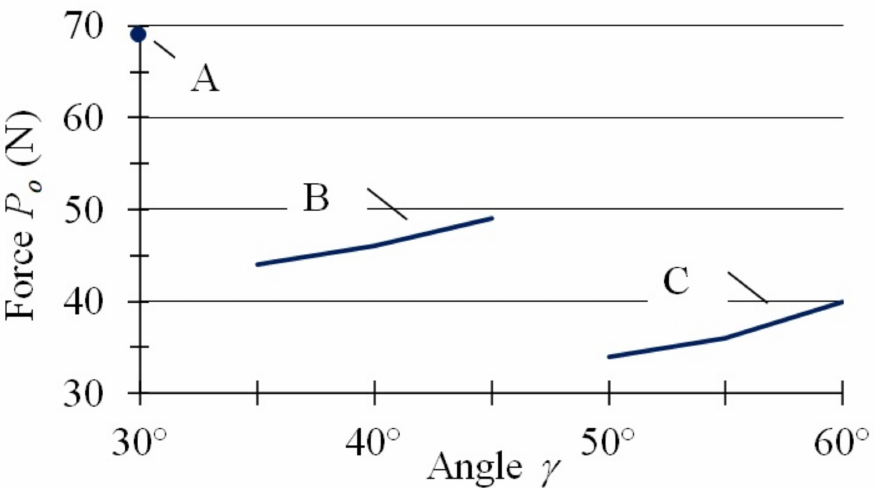
Figure 8. The dependence on the soil tillage resistance P o on the angle γ for different values of the angle (cid:101) : 60 ◦ (point A); 45 ◦ (curve B); and 30 ◦ (curve